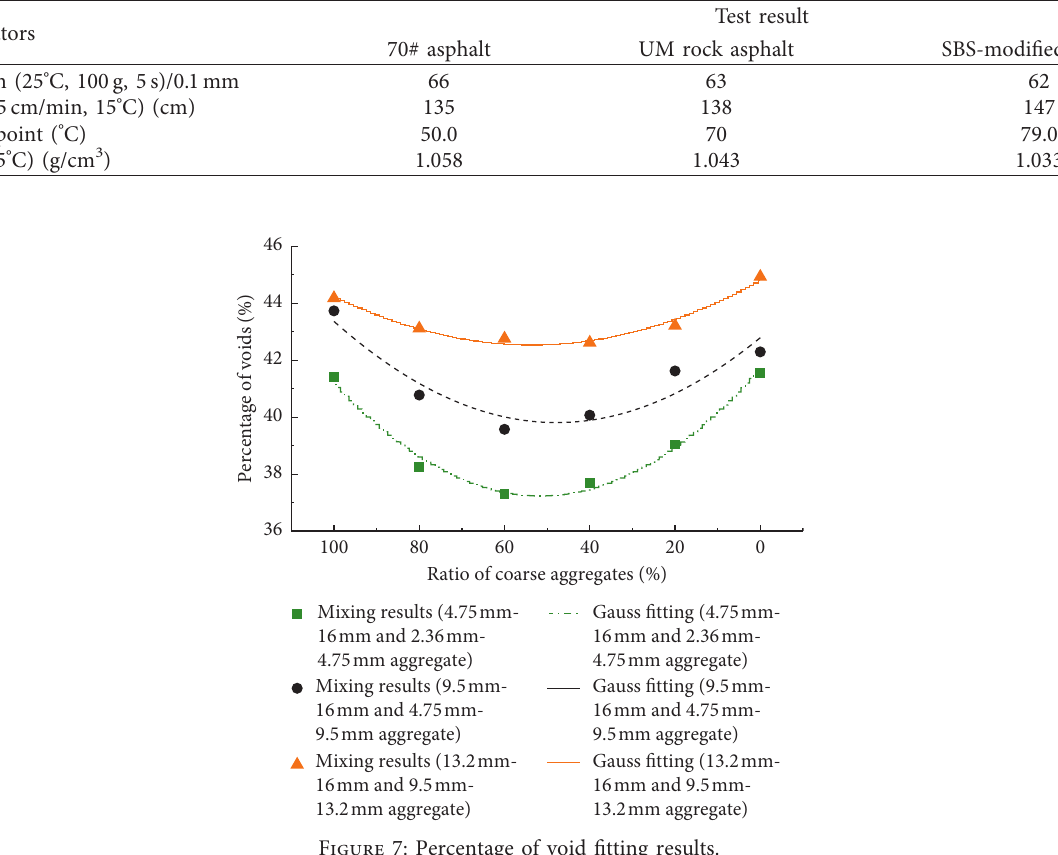
Table 4: Properties of asphalt.